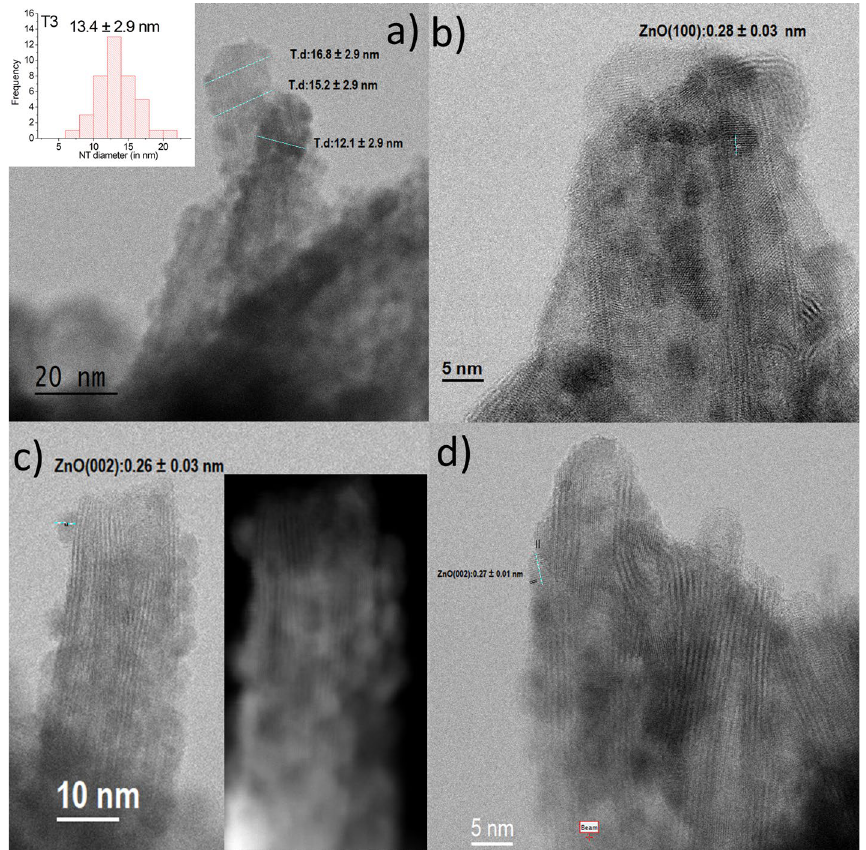
Figure 9. BF and HAADF STEM of T3. T3 STEM micrographs showing widening deterioration, the waveform of NTs, and ZnO crystallographic orientations at 60 kV in Nion Ultra STEM™ 100MC ’HERMES’ (a–f). ( a ) BF and histogram of T3 NTs diameter distribution (inset), ( b ) BF (Figure S19 in ESI shows additional STEM/EELS micrograph), ( c ) BF versus HAADF (inset), ( d ) BF.